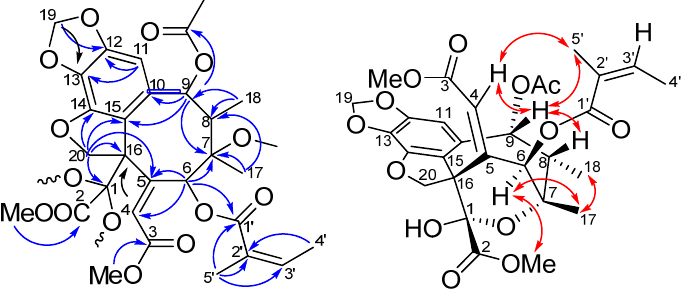
Figure 2. Selected HMBC (arrow) and NOESY (double headed arrow) correlations of 1